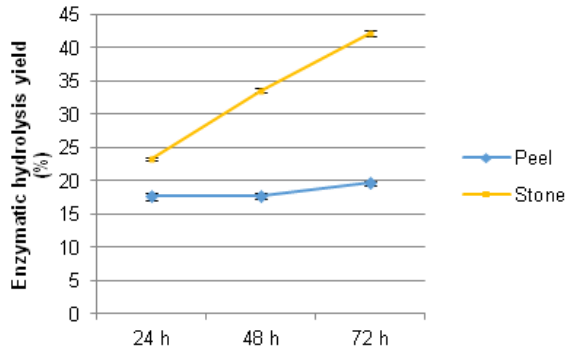
Figure 8. Enzymatic hydrolysis yield in terms of the glucose of the avocado waste.